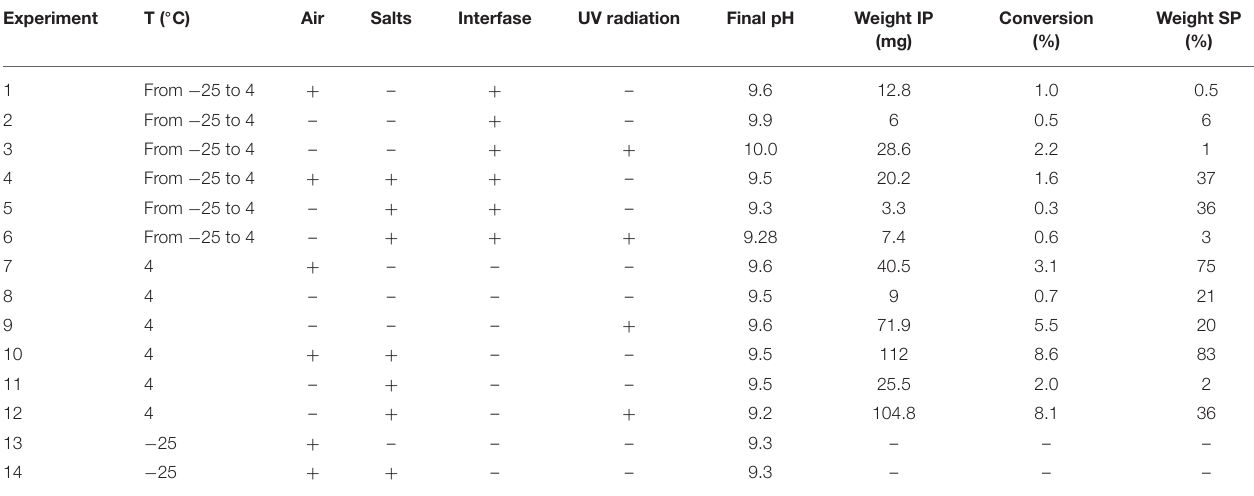
TABLE 1 | Experimental conditions used to study the effects of ice-water interfaces, UV-radiation and salts on ammonium cyanide polymerization.